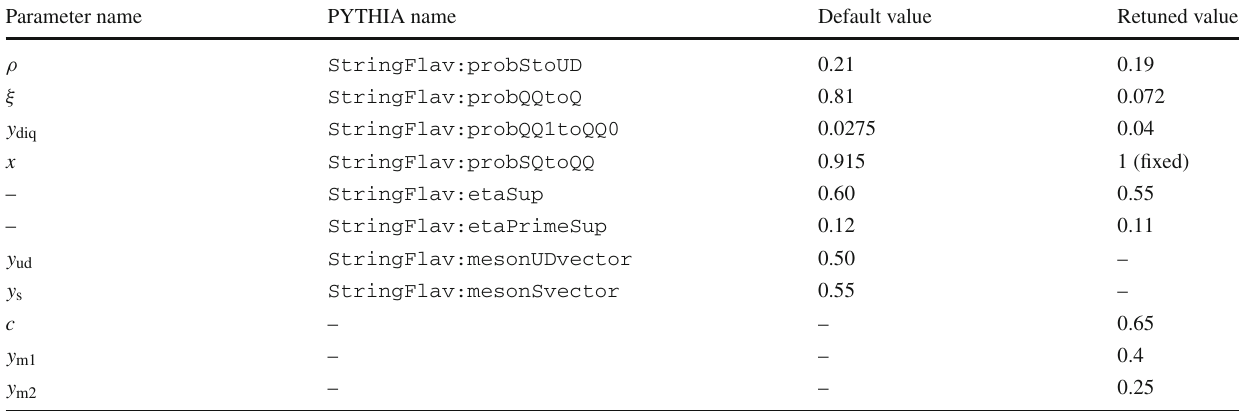
in the second column, followed by the default and retuned values. As it can be seen directly from the table, the number of free parameters in the default and the updated models are the